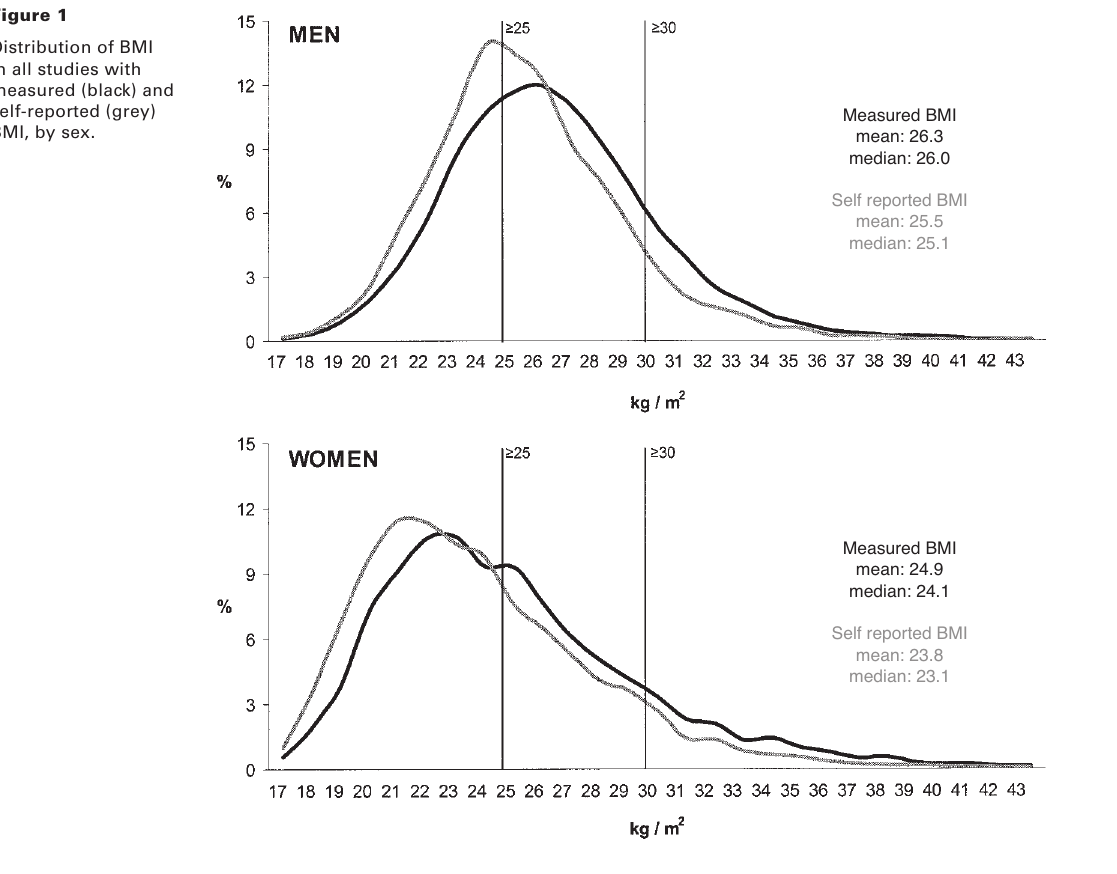
Mean (%) prevalence of obesity by study (measured: black; self-reported: grey) in men and women. Trend lines were obtained by linear